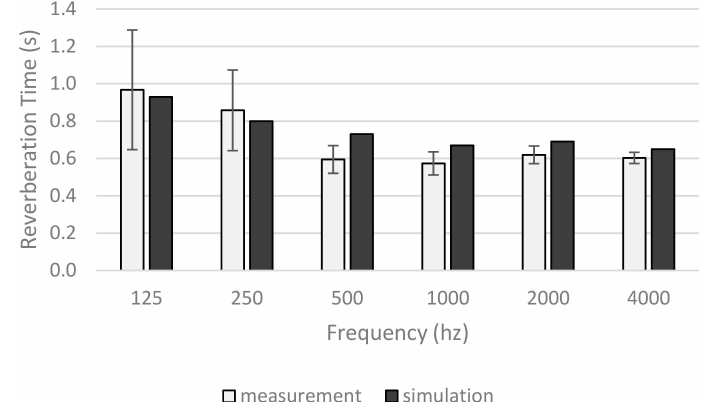
Figure 4. Comparison between simulated and measured values of the Reverberation Time (RT) in the case study. The error bars indicate plus and minus the standard deviation of the